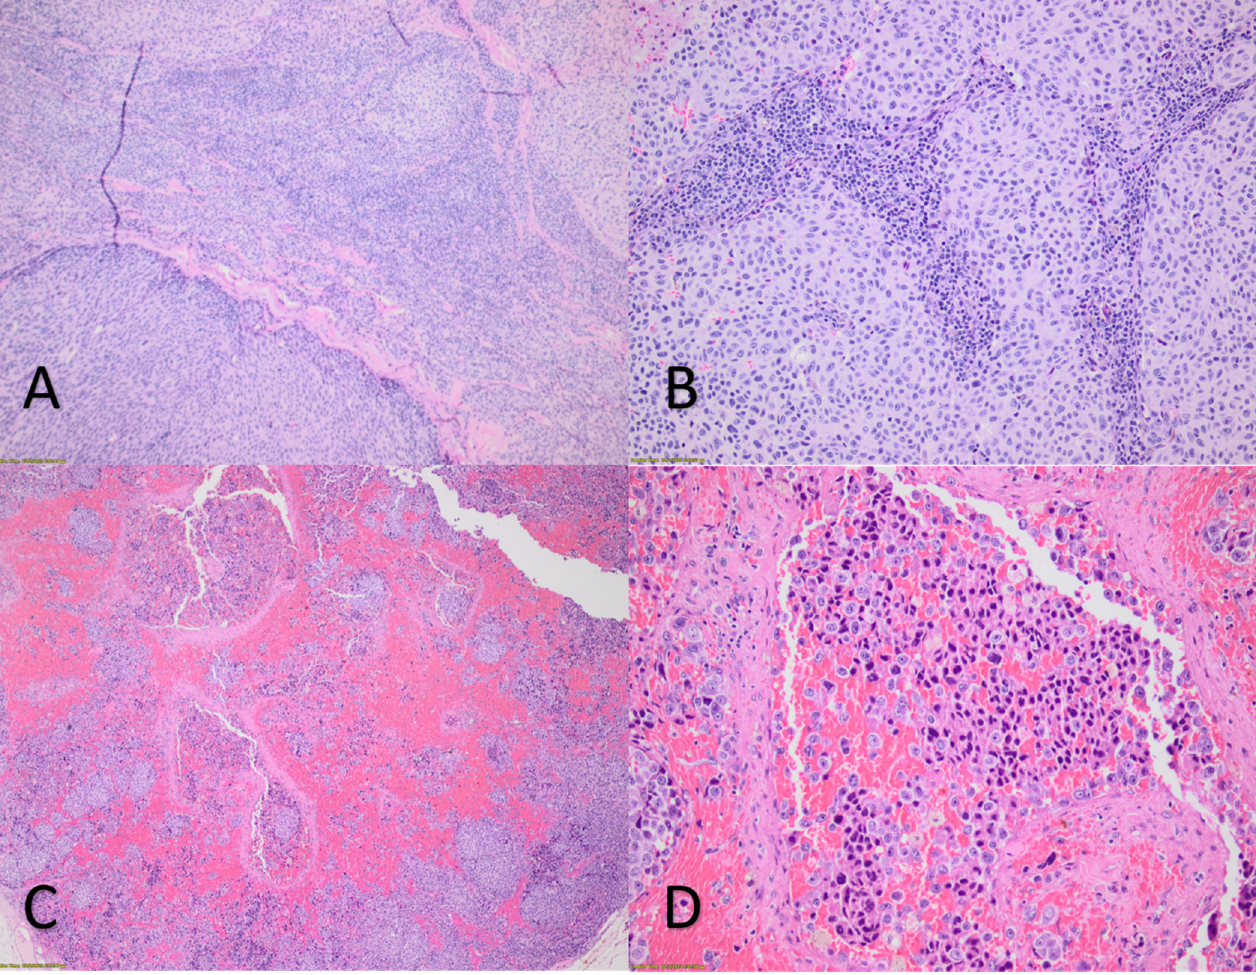
Figure 1. ( A ): Skin nodule—metastatic melanoma before mRNA vaccine. Epithelioid and neoplastic spindle cells. H-E stain at 4×. ( B ): Skin nodule—metastatic melanoma before mRNA vaccine. Lymphocytic infiltration. H-E stain at 20×. ( C ): Skin nodule—metastatic melanoma after mRNA vaccine. Prominent hemorrhagic deposits and necroses. H-E stain at 4×. ( D ): Skin nodule—metastatic melanoma after mRNA vaccine. Marked nuclear atypia and polymorphism—no lymphocytic infiltration. H-E stain at 20× (by conventional light microscope).